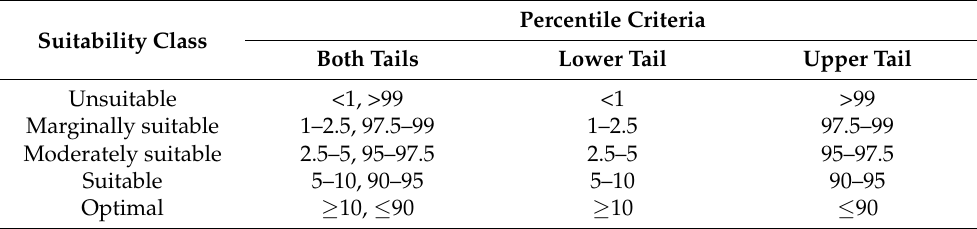
Table 1. Percentiles for grading land suitability for growing